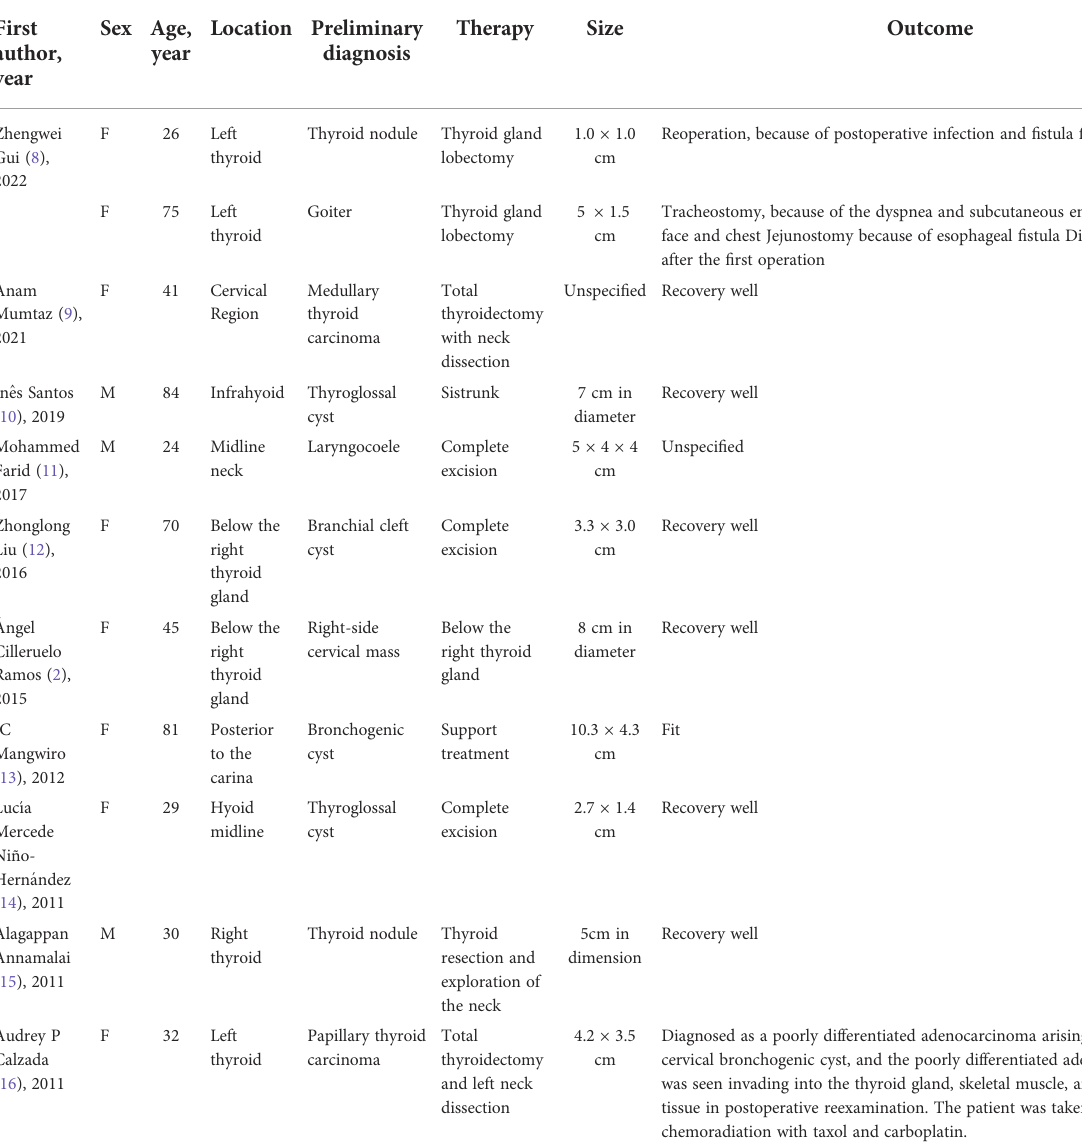
TABLE 1 Review of cases of CBCs in adults over the last 15